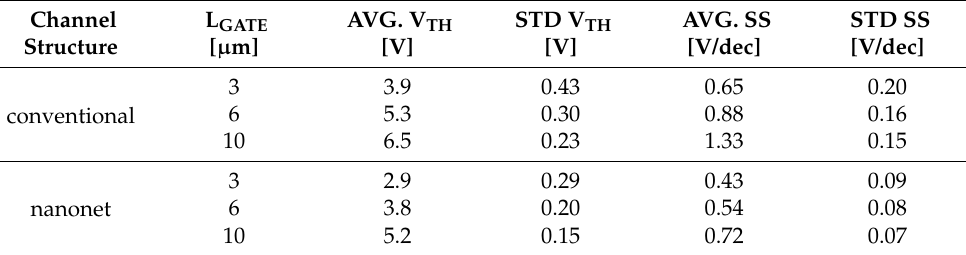
Table 1. Average and standard deviation of V TH and SS for NET_TFTs and CON_TFTs with different L GATE